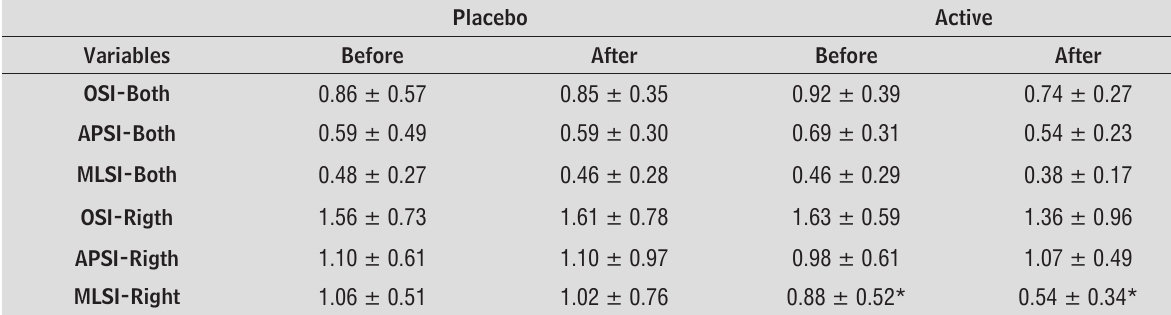
Table 1. The variables evaluated did not demonstrate an intergroup difference after strength training program Table 1 - Stability Indexes